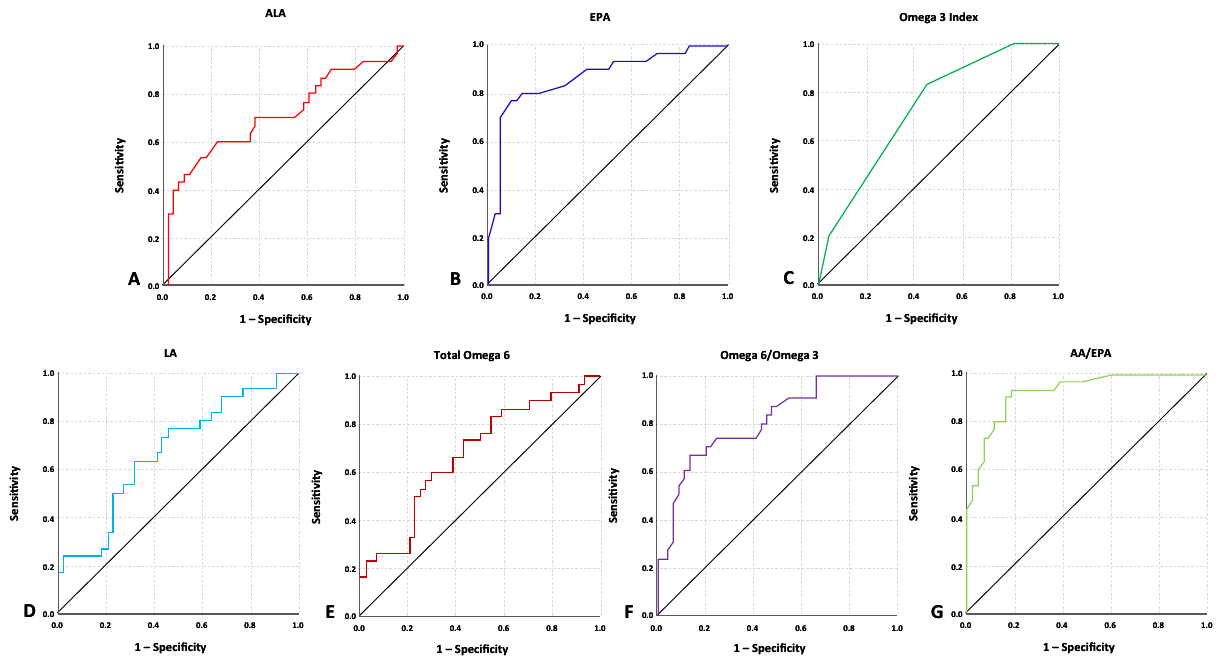
Figure 1. ROC curves of seven LCPUFA parameters which are considered to be acceptable predictors in showing the risk of severe preeclampsia by having AUC value > 0.650.